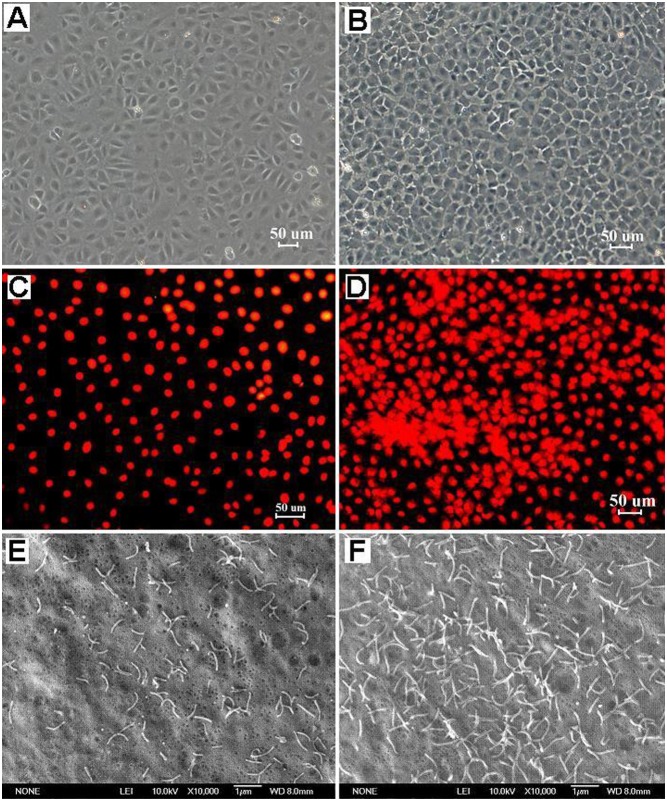
Morphological changes of APS-treated IEC-6 cells.Normal, untreated IEC-6 cells formed a simple monolayer of flat epithelial cells and were in an irregular arrangement with an immature shape (A). The untreated IEC-6 cells contained large, oval nuclei that exhibited red fluorescence by propidium iodide staining (C) and showed few microvilli on the apical surface under a scanning electron microscope (E). IEC-6 cells treated with APS (200 µg/mL) for 4 d were more closely packed together and showed many pseudopodia establishing intercellular contacts (B). The nuclei of APS-treated cells were arranged regularly in rows or clusters, implying those cells exhibited a tendency towards gland formation (D). The scanning electron micrograph showed numerous long, slender microvilli distributed over the apical pole of treated cells (F).